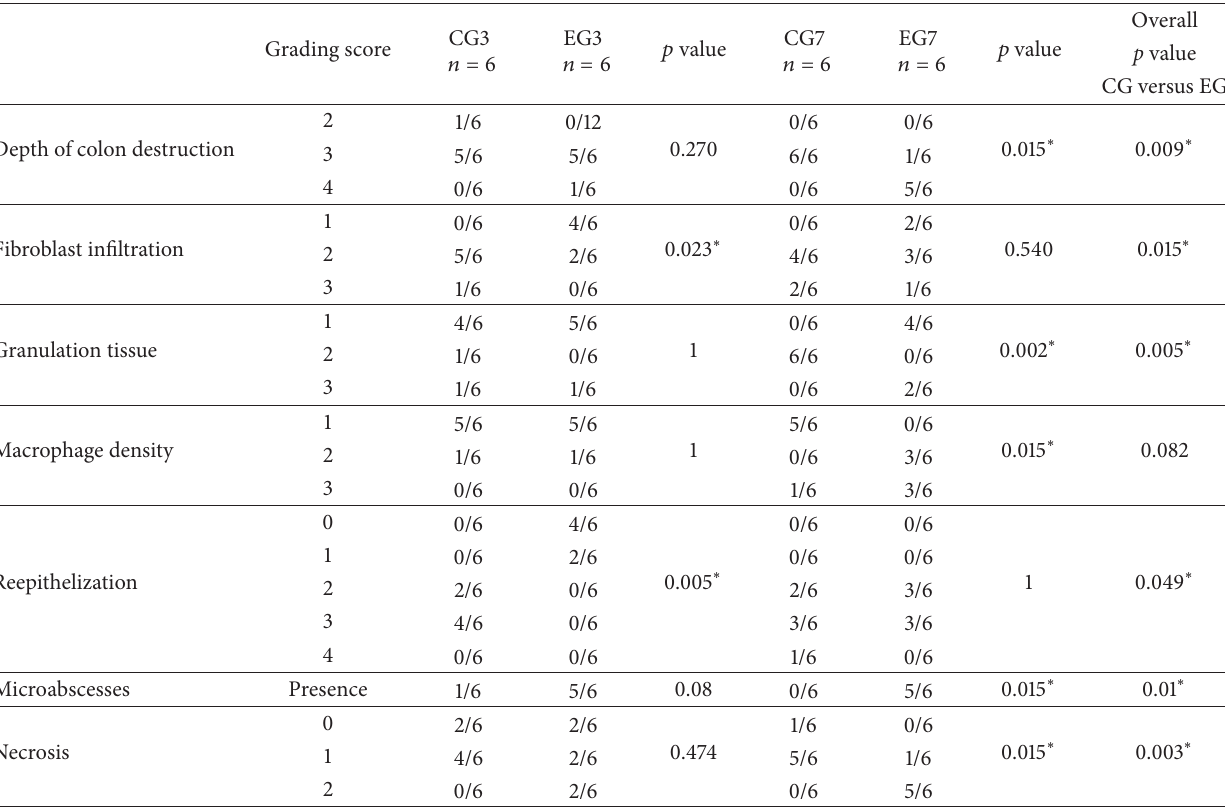
CG3:controlgroup3rdPOD,EG3:experimental (lornoxicam)group3rdPOD,CG7:controlgroup7thPOD,EG7:experimental (lornoxicam)group7thPOD, and 𝑛 : number of subjects. ∗ Statistical significance at the level of